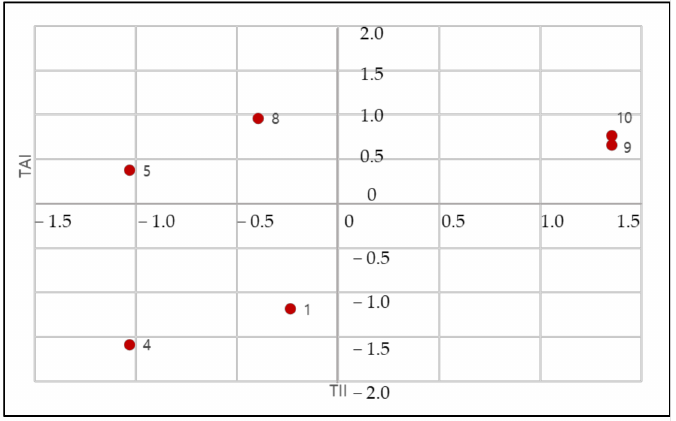
Figure 6. Results of the criticality analysis using a technology level